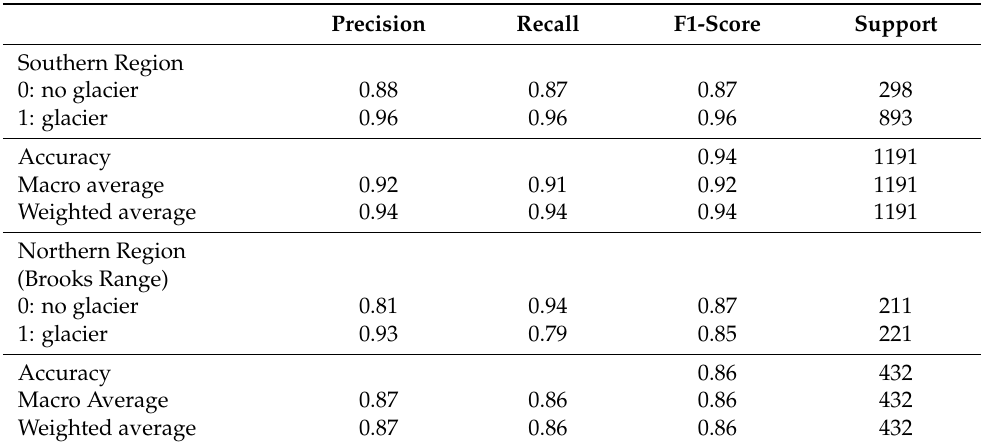
Table 4. Comparison of the 2016 target year point-based validation with GlacierCoverNet for glaciers in southern Alaska and the Brooks